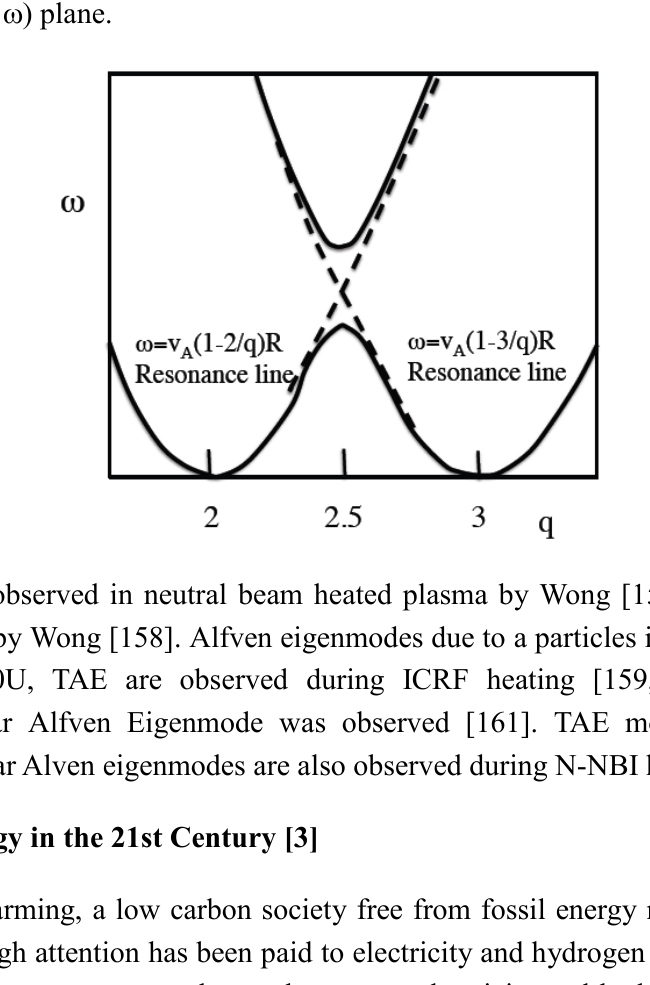
Figure 31. Alfven gap frequency structure due to toroidal mode coupling of m = 1 and m = 2 modes in (q,  )